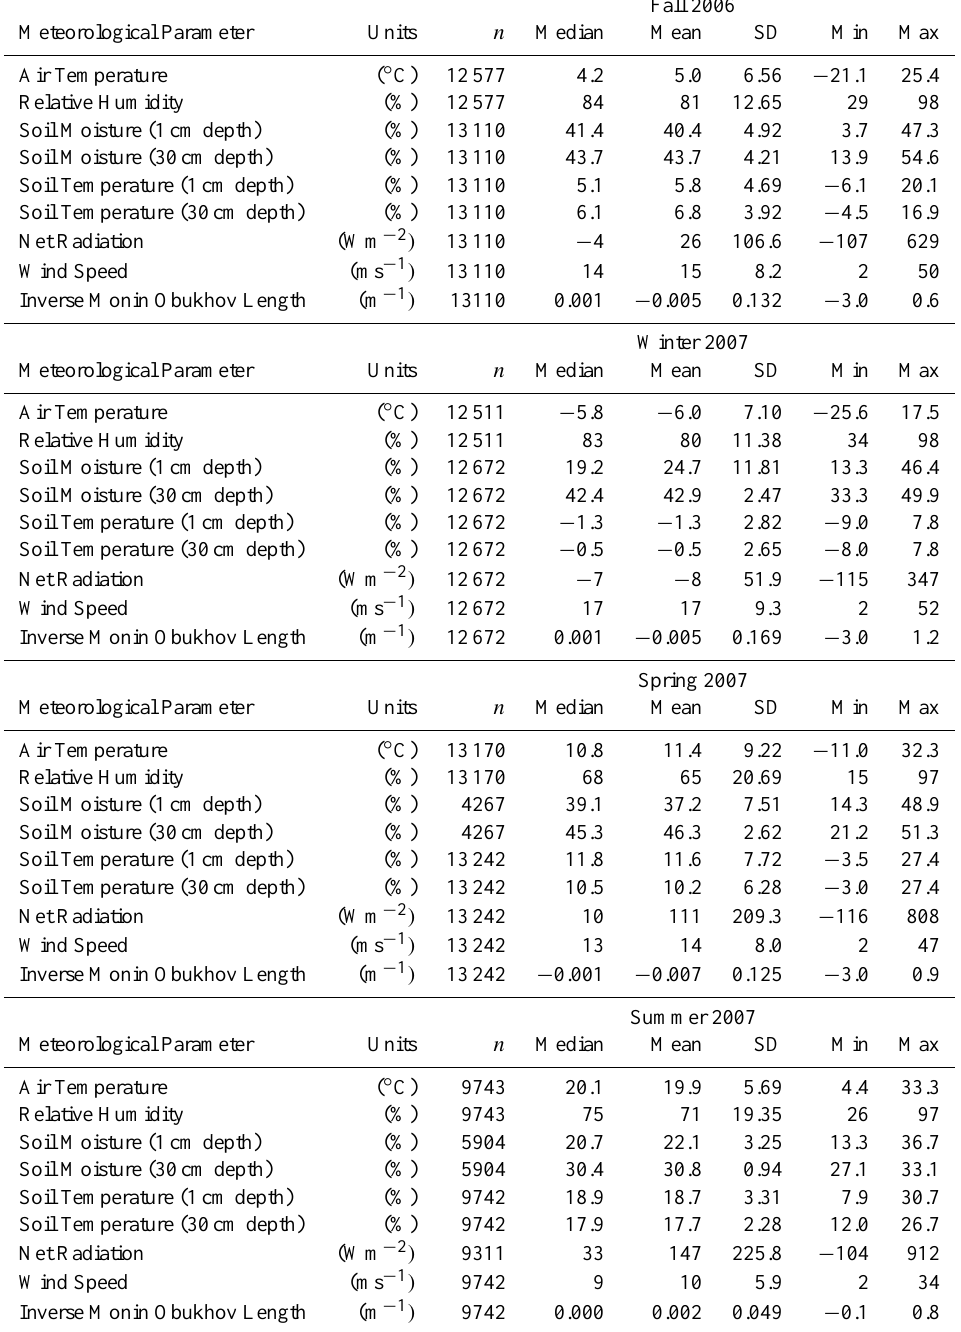
Table 2. Statistical summary of the environmental parameters measured during the study at Elora Research Station, ON from November 2006 to June